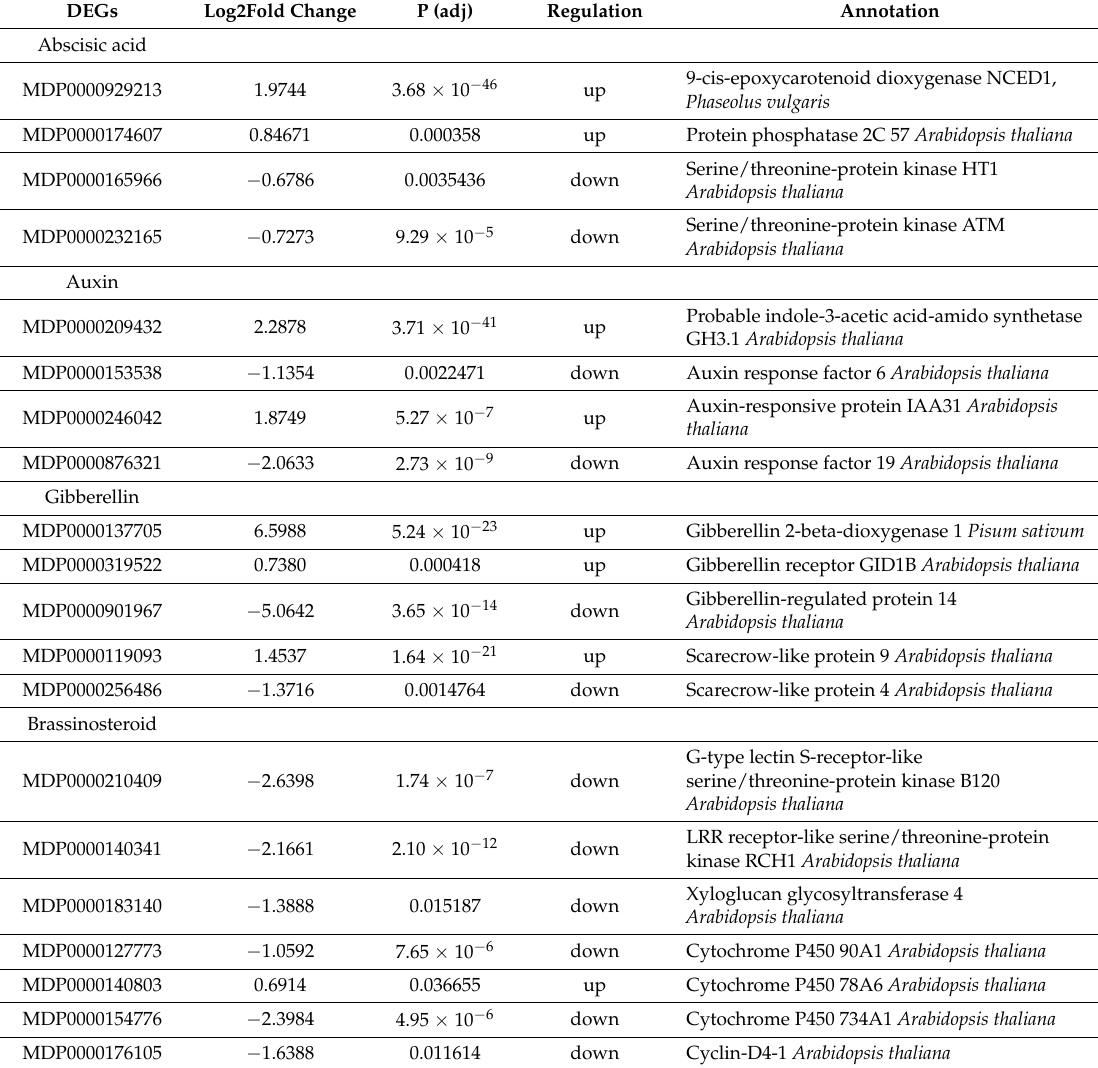
Table 3. DEGs related to plant hormones expressed in post-ripening (HY_20 ◦ C_5 vs. HY_4th) group.